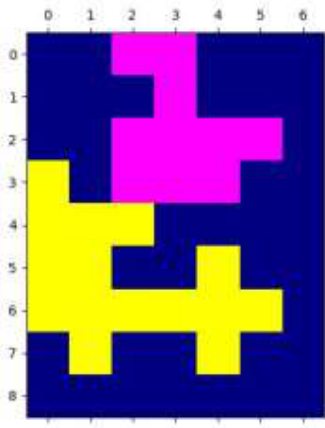
Figure 8. Simple test case –high threshold for being a storm element center